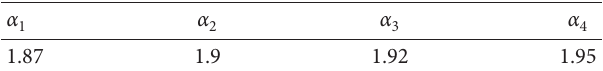
Figure 2: Concave function. Table 1: Order of fractional derivatives used for both